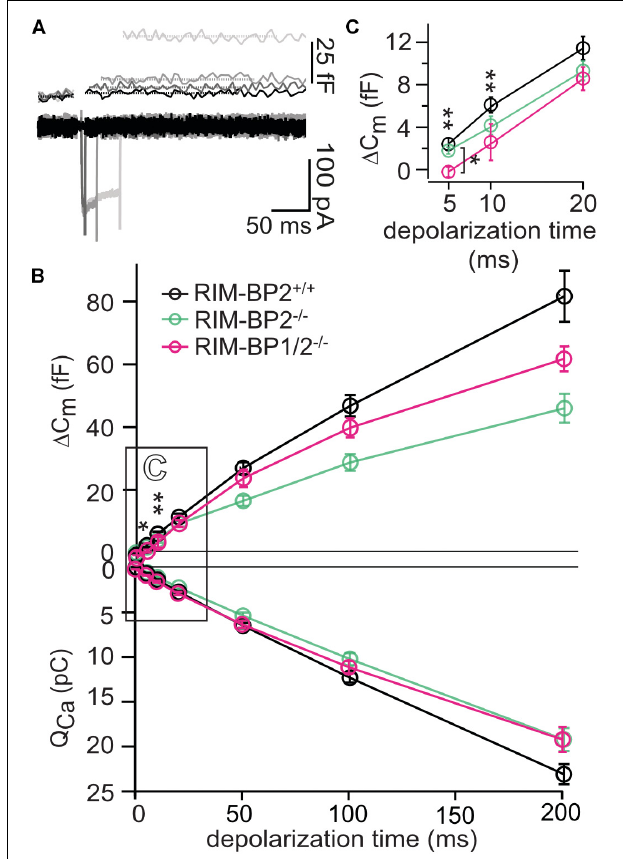
FIGURE 2 | RIM-BP1 promotes exocytosis of the RRP. (A) Representative C m traces and their corresponding Ca 2 + -currents (I Ca ) from an individual RIM-BP1/2-deficient IHC in response to various depolarization durations to − 14 mV (indicated by different gray values) from a perforated patch-clamp recording. The C m data of the first 100 ms after the depolarization containing a non-exocytic C m transient have been removed as they are discarded for the analysis of the exocytic C m change ( (cid:49) C m ). The horizontal lines represent the average C m before and after the depolarization. Scale bar: 50 ms, 25 fF (C m ), 100 pA (I Ca ). (B) Relationship of (cid:49) C m (top) and the corresponding whole-cell Ca 2 + -current integrals (Q Ca , bottom) of RIM-BP1/2-deficient ( RIM-BP1/2 − / − , n = 8, magenta), RIM-BP2-deficient ( RIM-BP2 − / − , n = 10, green) and control ( RIM-BP2 + / + , n = 12, black) IHCs for various depolarization durations to − 14 mV. (C) Responses to short depolarizations [black box in panel (B) ] are magnified for better display. For various depolarization durations, exocytic (cid:49) C m of RIM-BP1/2-deficient IHCs differed significantly from control IHCs (indicated by asterisk on top of traces, 5 ms: p = 0.003, 10 ms: p = 0.04). Compared to RIM-BP2-deficient IHCs, a difference in exocytic (cid:49) C m of RIM-BP1/2-deficient IHCs was detected for 5 ms IHC depolarization duration (indicated by asterisk and bracket, p = 0.03). (B,C) Data information: Data represent IHC grand averages, mean ± SEM; one-way ANOVA and for multiple comparisons, post-hoc Tukey’s test, p -values are summarized in Table 3 . Significance levels: n.s. p ≥ 0.05, * p < 0.05, ** p < 0.01; n = number of IHCs; age of mice: p14-p16. Data of RIM-BP2-deficient ( RIM-BP2 − / − , n = 10, green) and control ( RIM-BP2 + / + , n = 12, black) IHCs were adapted from Krinner et al. (2017).